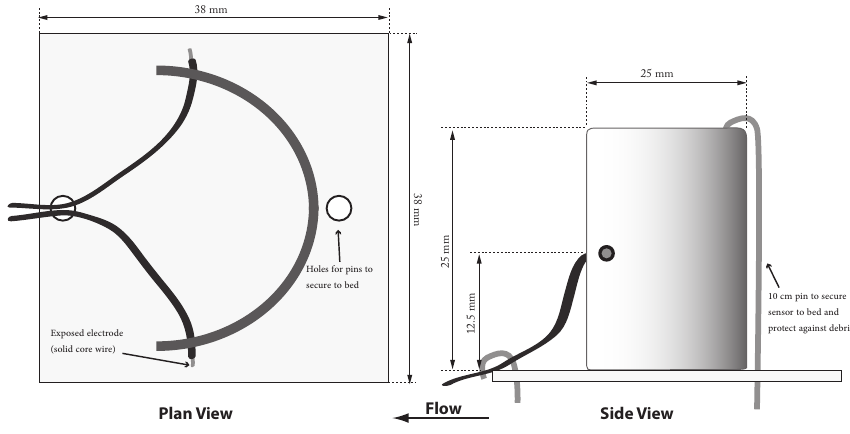
Fig. 1. Electronic resistance (ER) sensor schematic. cut to 38 × 38 mm squares and attached using the same